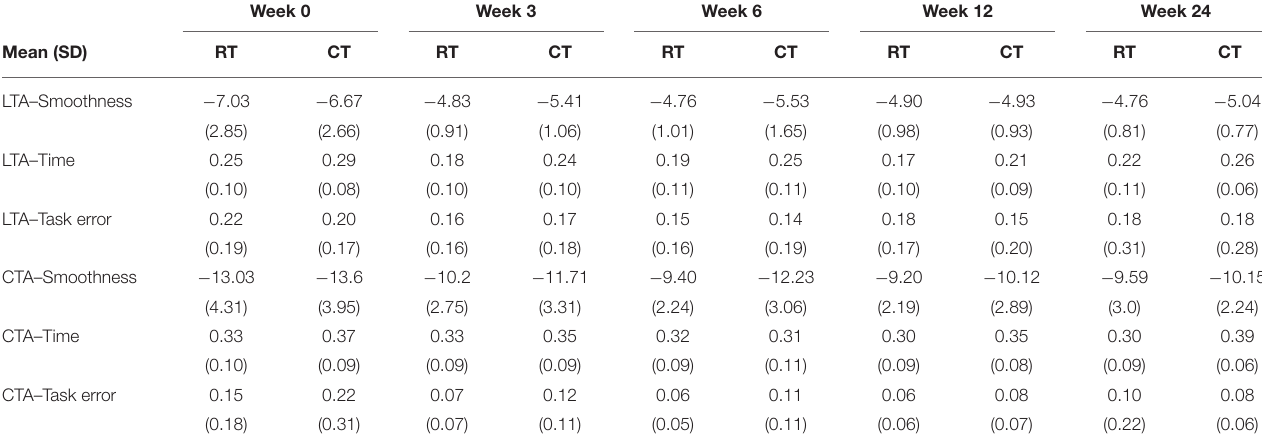
FIGURE 4 | Distribution of quantitative measures across sessions in the line tracing assessment (A–C) and in the circle tracing assessment tasks (D–F) . Median and standard error of: smoothness, measured by SPARC; temporal efficiency, measured by normalized time to peak velocity ( T peakN _ Abs ); and task deviation error, measured by Length of Curves (LOC) across the five assessment sessions are shown. The * signifies that the scores are significantly different from the baseline scores ( p < 0.05). The ⋄ signifies a significant difference in the changes of robotic measures between both groups ( p < 0.05). Wk, week. TABLE 3 | Robotic metric outcome measures by training group over time points ( n =